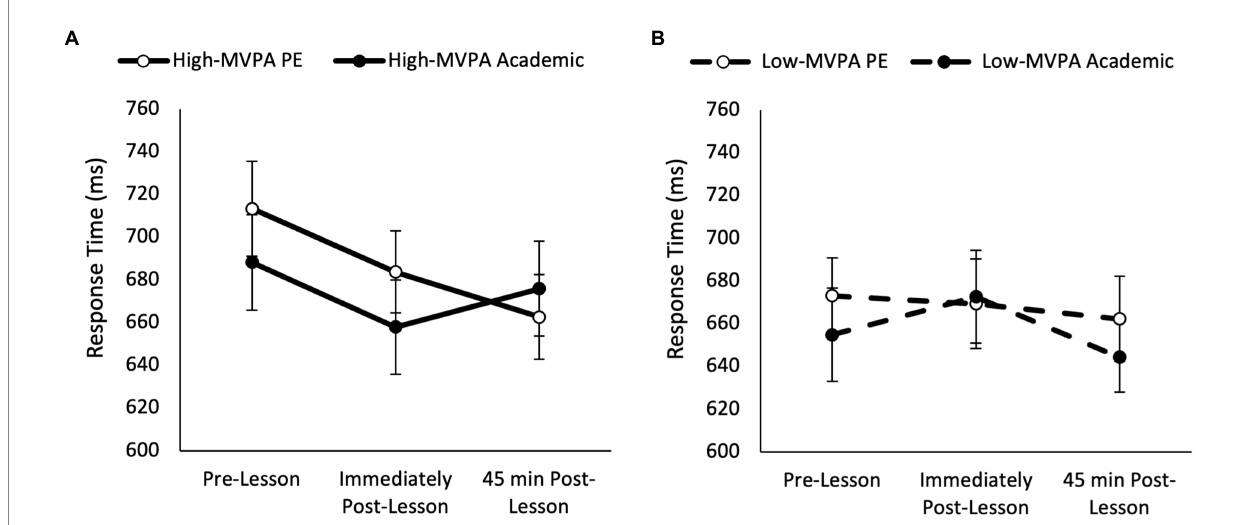
FIGURE 3 Response times across the morning on the three item level of the Sternberg paradigm on the PE and academic lesson trials for the high MVPA (trial * time, p = 0.012; A ) and low MVPA (trial * time, p = 0.443; B ) groups (trial * time * MVPA, p =